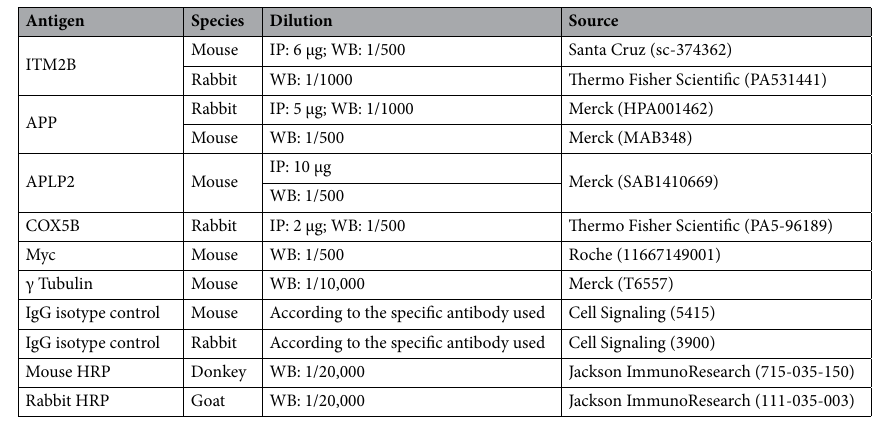
Table 1. List of primary and secondary antibodies used for immunoprecipitation and Western blot. IP immuno-precipitation, WB western blot, HRP horseradish